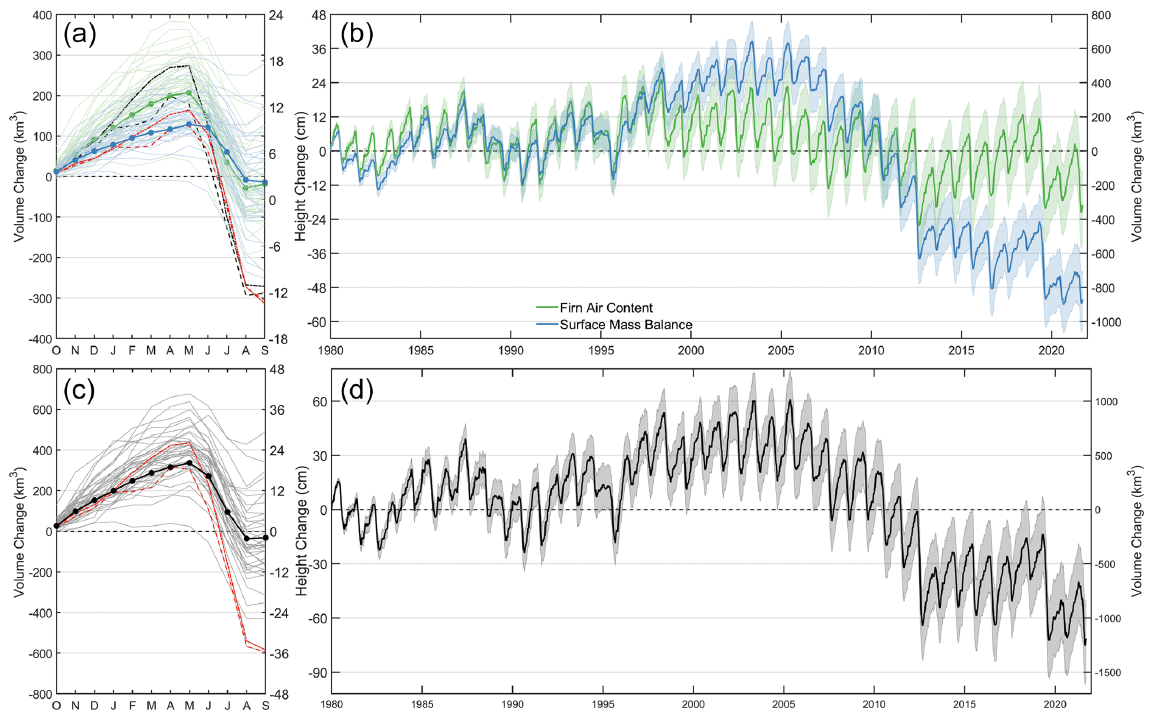
Figure 16. Height and volume change of the Greenland Ice Sheet. (a) Seasonal changes separated into surface mass balance (SMB; blue) and firn air content (FAC; green) components. The thin lines represent each year, and the thick, dotted line represents the mean over the RCI (1980–1996). The solid and dashed lines represent the 2012 and 2019 mass balance years, respectively, where the black lines represent FAC and the red lines represent SMB. (b) A 40-year time series of volume and height change due to SMB and FAC. (c, d) The FAC and SMB combined height and volume change. The shaded regions represent the cumulative 2 σ uncertainty in the volume changes, which accounts for spatial and temporal correlation in the time series. Note the differences in scale.